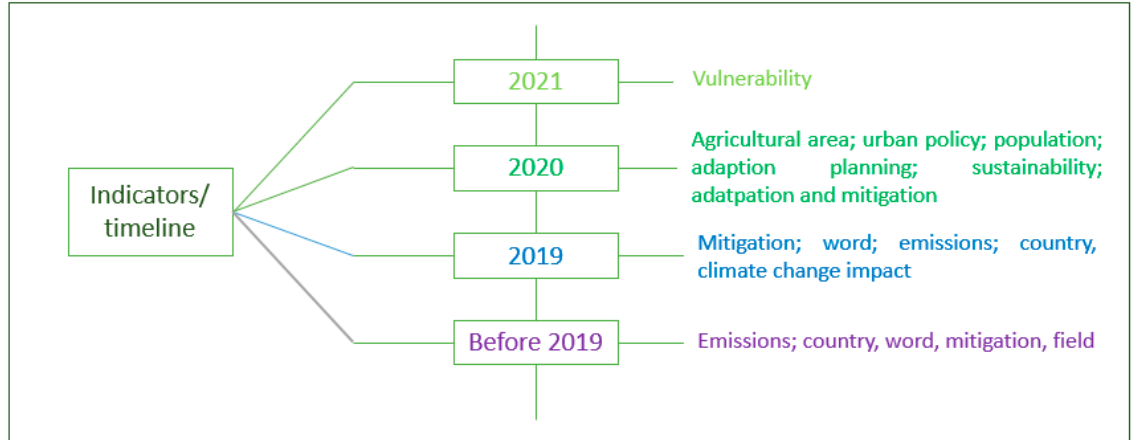
Figure 4. Main Indicators (Clusters). Notes: Elaborated by the authors based on the literature on VOSviewer Software (2022).